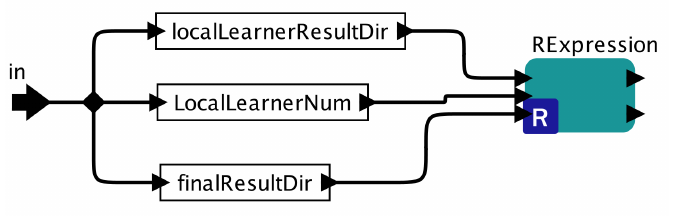
Figure 6. Global Ensemble Sub-workflow.